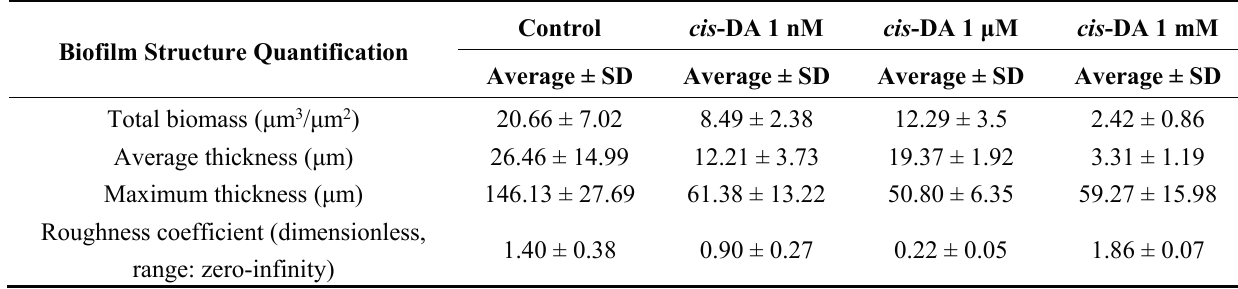
Table 2. COMSTAT analysis of P. aeruginosa PAO1 harboring the green fluorescence protein expressing vector pMRP9-1, grown in flow cell reactors in EPRI media, in the continuous presence of different concentrations of cis -DA. Results are the average of at least 4